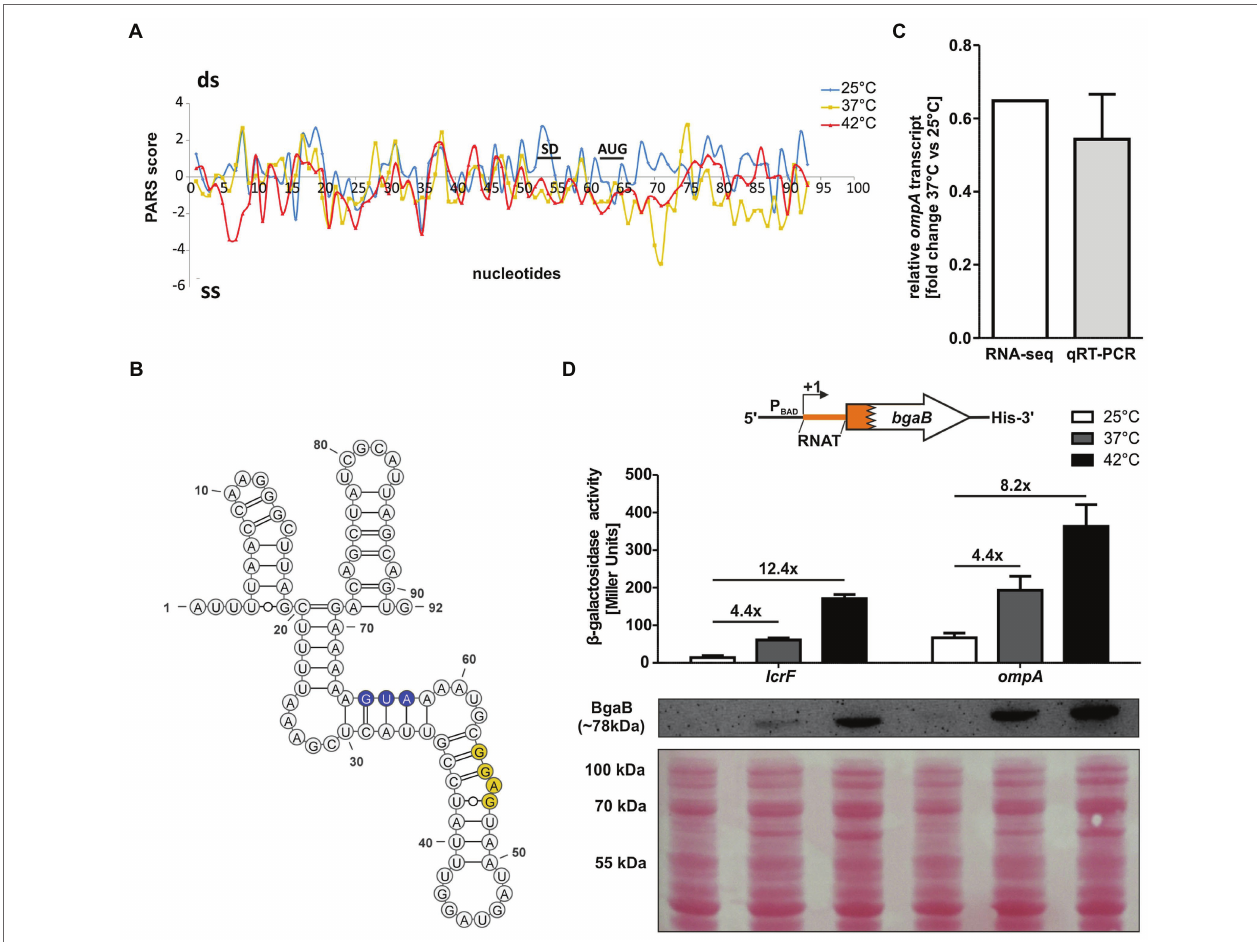
FIGURE 1 | The ompA 5 ' -UTR contains a thermoresponsive RNA structure. (A) PARS profiles of the ompA RNAT ( − 62 nt to +30 nt from AUG) at 25, 37, and 42 ° C (Righetti et al., 2016). The potential SD sequence and the AUG are shown. A positive PARS score is indicative of a double-stranded (ds) conformation, whereas a negative PARS score suggests a single-stranded (ss) conformation. A drop from a positive score at 25 ° C to a negative score at 37 ° C suggests melting of a secondary structure. (B) PARS-derived secondary structure of the ompA RNAT at 25 ° C. The potential SD sequence is highlighted in yellow and its corresponding AUG in blue. –, AU pair; =, GC pair; and ○ , GU pair. (C) Comparison of ompA transcript amount between 37 and 25 ° C by RNA sequencing (Nuss et al., 2015) and qRT-PCR (this study) of exponentially grown YPIII cells at 25 and 37 ° C, respectively. For qRT-PCR, the obtained data were normalized to gyrB and nuoB . qRT-PCR was prepared in biological triplicates and technical triplicates. (D) Translational control was measured by bgaB fusions. A schematic representation of the reporter gene fusion is displayed. The ompA RNAT was translationally fused to bgaB under control of the P BAD promotor. As a control, the lcrF RNAT fusion was used. The fusion plasmids were introduced into E. coli cells and grown to an OD 600 of 0.5 at 25 ° C. Subsequently, transcription was induced by the addition of 0.01% L-arabinose and the cultures were split and transferred into pre-warmed flask at 25, 37, and 42 ° C, respectively. After 30 min of incubation, samples were taken for β -galactosidase assays and Western blot analysis. Experiments were carried out in biological triplicates. Mean and corresponding standard deviations are shown. Western blot membranes were stained with Ponceau S as a loading control. One representative Western blot is shown. Analysis was carried out in biological